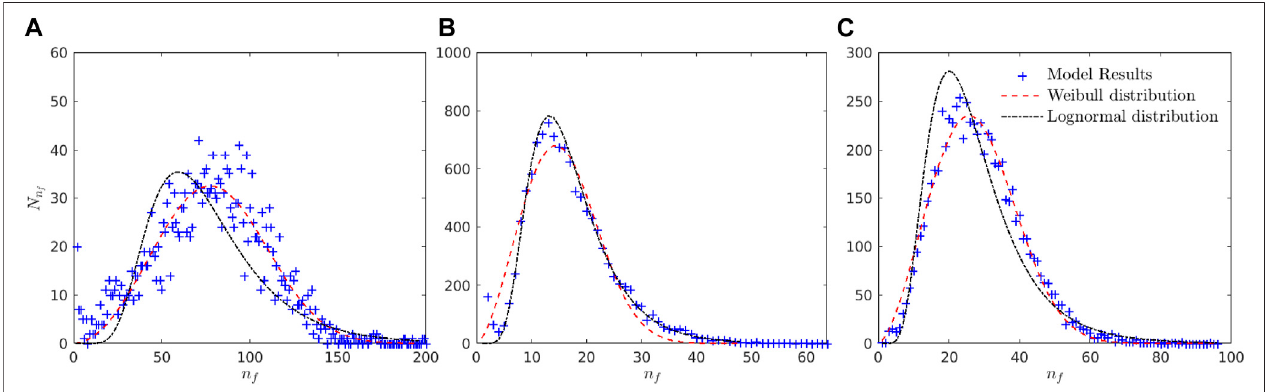
FIGURE 9 | Floc size distribution represented by N n